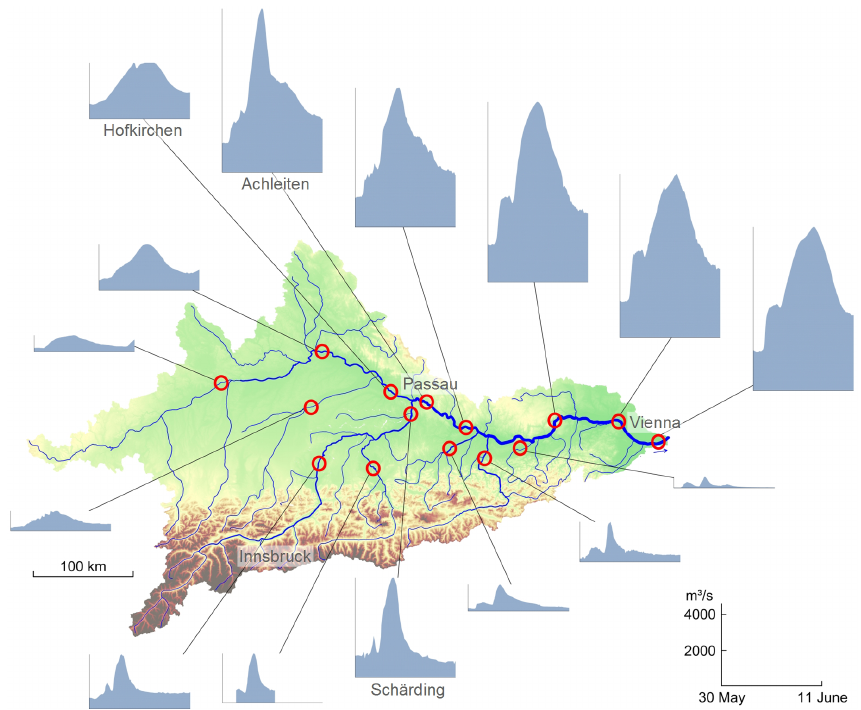
Figure 8. Spatial flood hydrograph pattern of the 2013 event in the Danube basin upstream of Vienna, Austria. Red circles indicate the stream gauges. The scale shown on the bottom right relates to all hydrographs (light blue areas). From Blöschl et al.